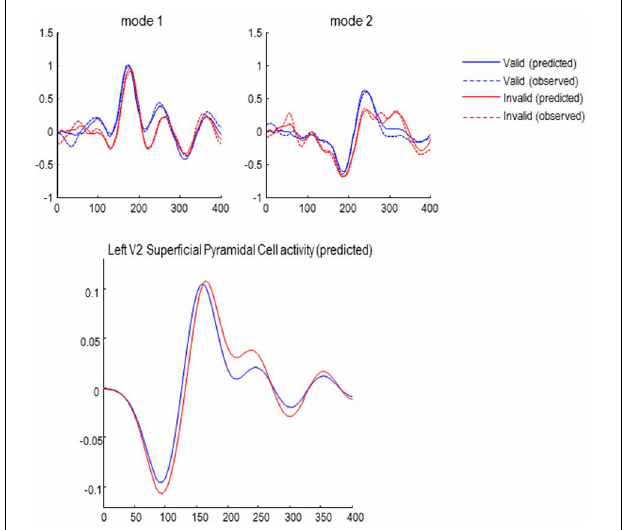
FIGURE 6 | Upper panel: the first two of eight spatial modes (principle components) of the data to which the DCMs were fitted. Observed responses are dashed lines; solid lines show the responses fitted by the winning model (see below), demonstrating a good model fit. Lower panel: reconstructed source activity in left